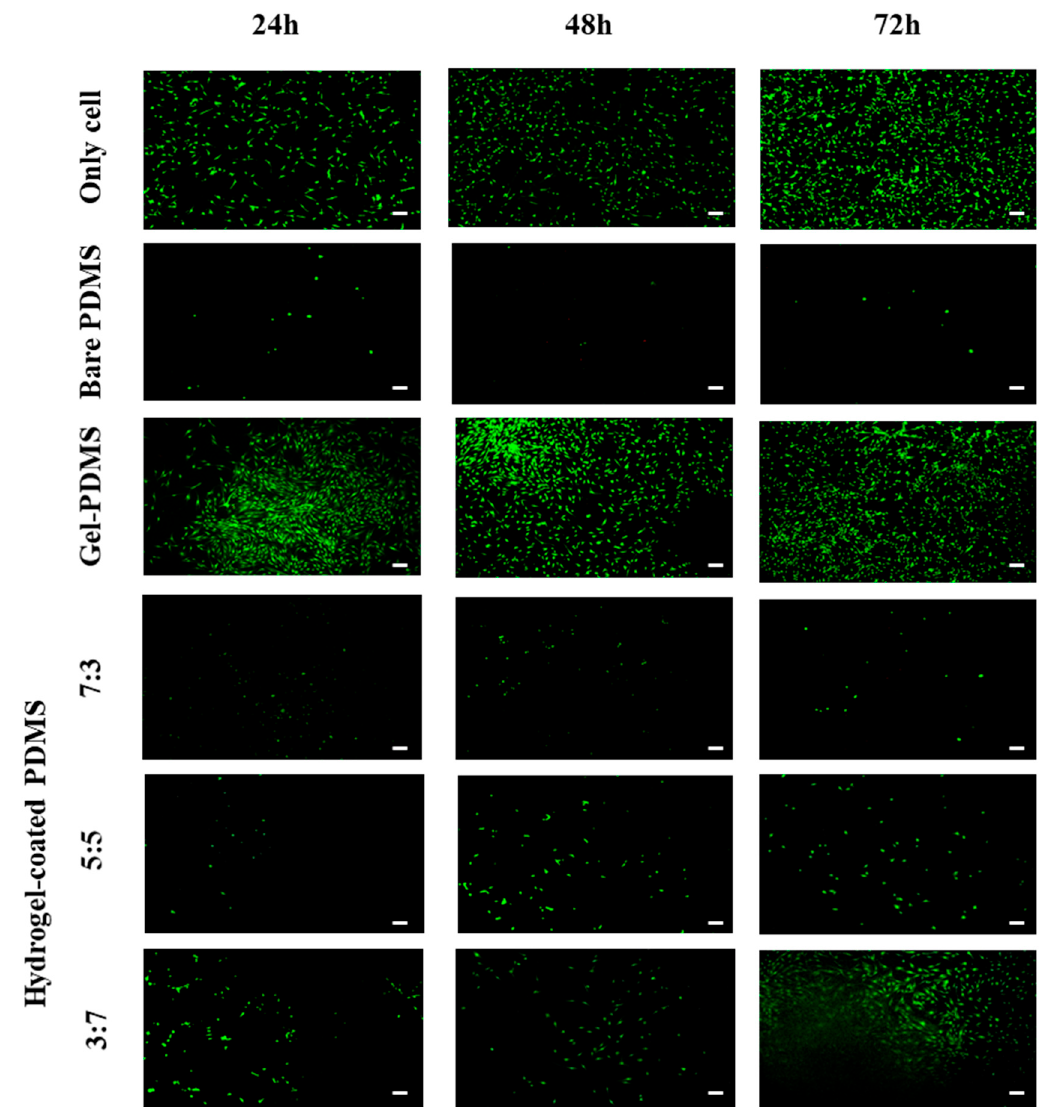
Figure 8. Cell viability on the surfaces of bare poly(dimethylsiloxane) PDMS and PDMS modified with gelatin and hydrogel composed of CHO–HA/Gel–NH 2 . (The scale bar represents 100 µm.).